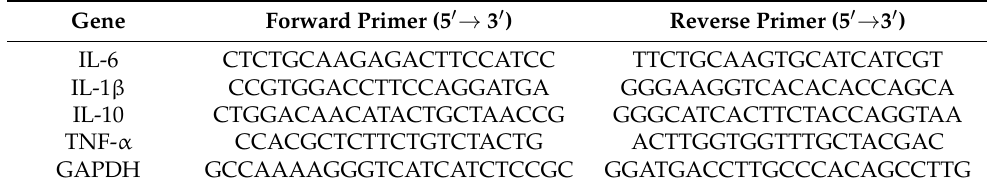
Table 2. Primers used for real-time PCR.